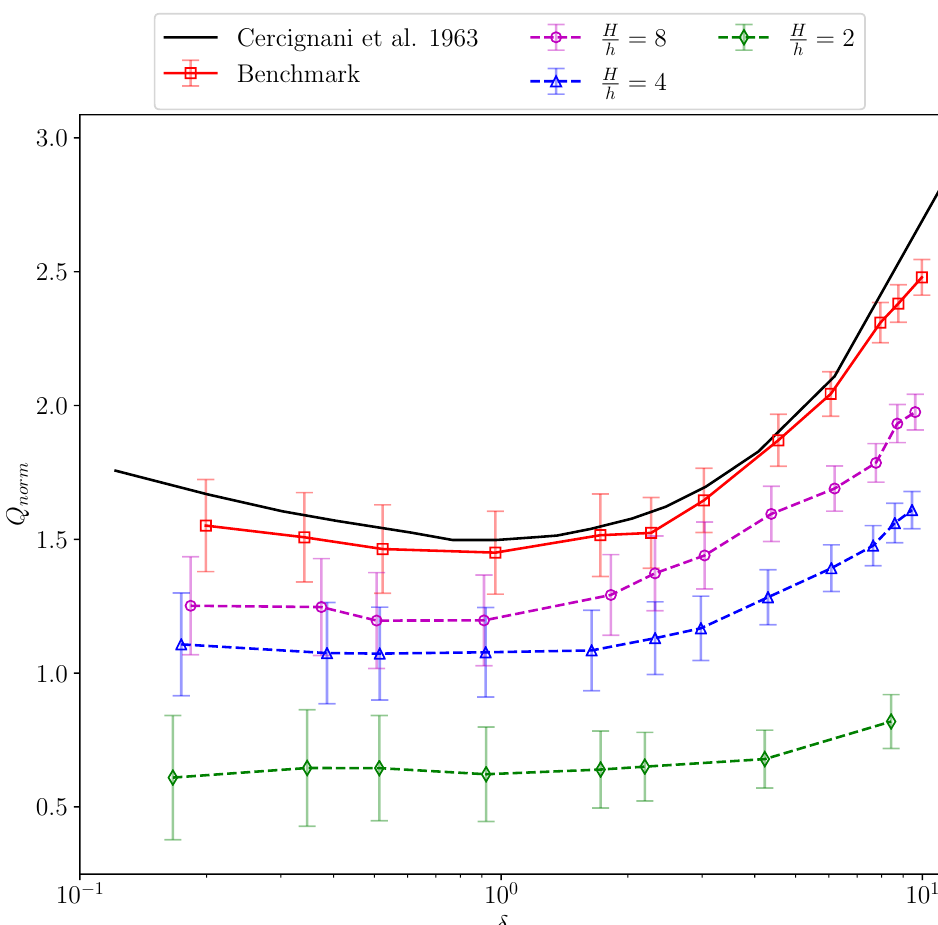
Figure 4. Knudsen paradox in 2D planar micro-channel Poiseuille flows with a stationary particle in the middle. The solid line ( ) represents the results obtained by Cercignani et al. [5,8], while the red line ( ) with open squares represents the benchmark results (without a particle). The dashed lines represent the results obtained from the DSMC simulations of a micro-channel at blockage ratios H / h of 8, 4 and 2, respectively. The error bars indicate the statistical spread ( in the sampled data. Note that the error bars increase as H / h decreases (or the particle size increases) since the local Knudsen number in the restrictions created by the particle is